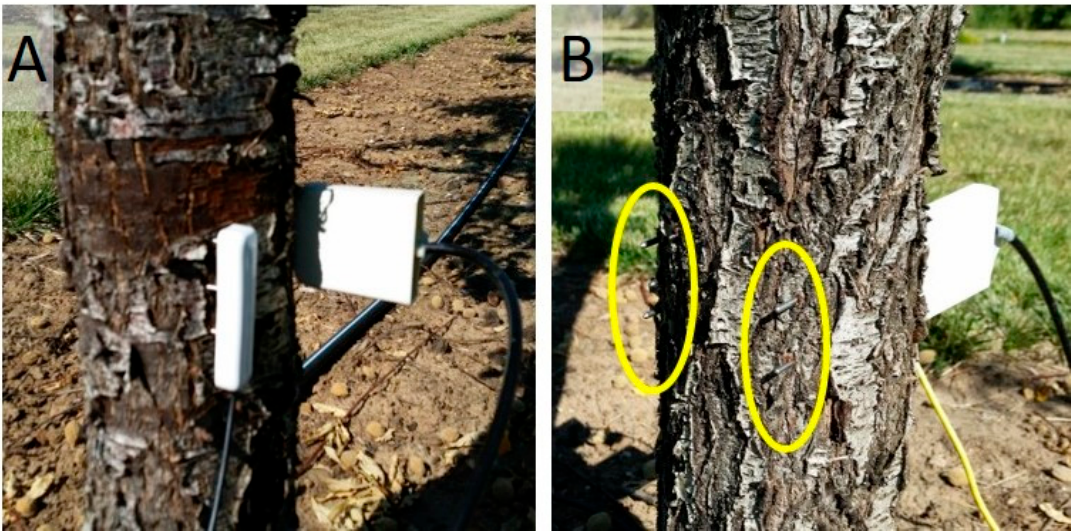
Figure 2. ( A ) GS3 and CS655 installed in a peach tree trunk revealing some exposed waveguide near the sensor head. ( B ) CS655 and TDR-315(L) sensors protruding through a peach tree